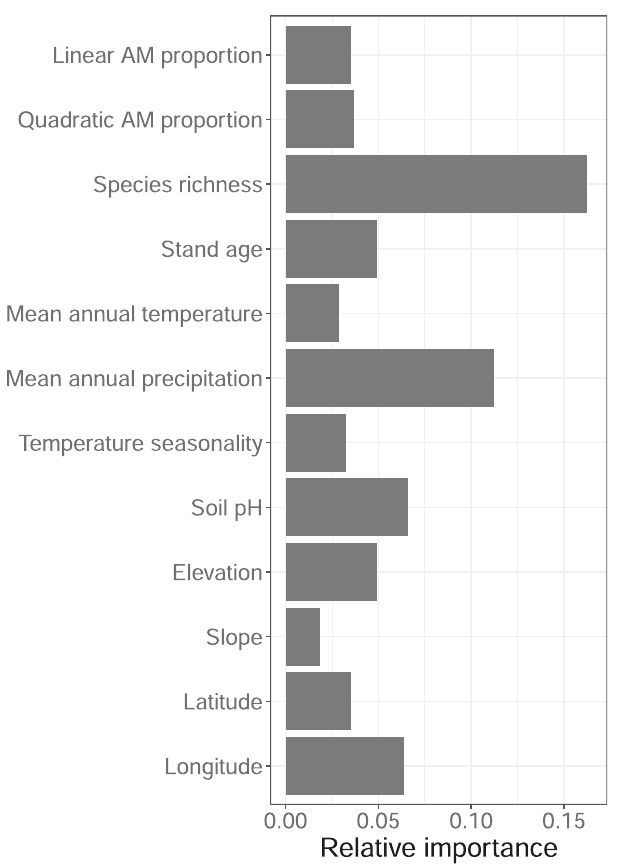
Fig. 3 | Relative variable importance from random forest model explaining forestproductivity. Relative variable importanceisthe meandecrease insquared error caused by each of the variables, rescaled such that it sums up to the total pseudo-R 2 of the whole model. The overall explained variation (R 2 ) of forest pro- ductivity is 0.69. Source data are provided as a Source Data fi le.